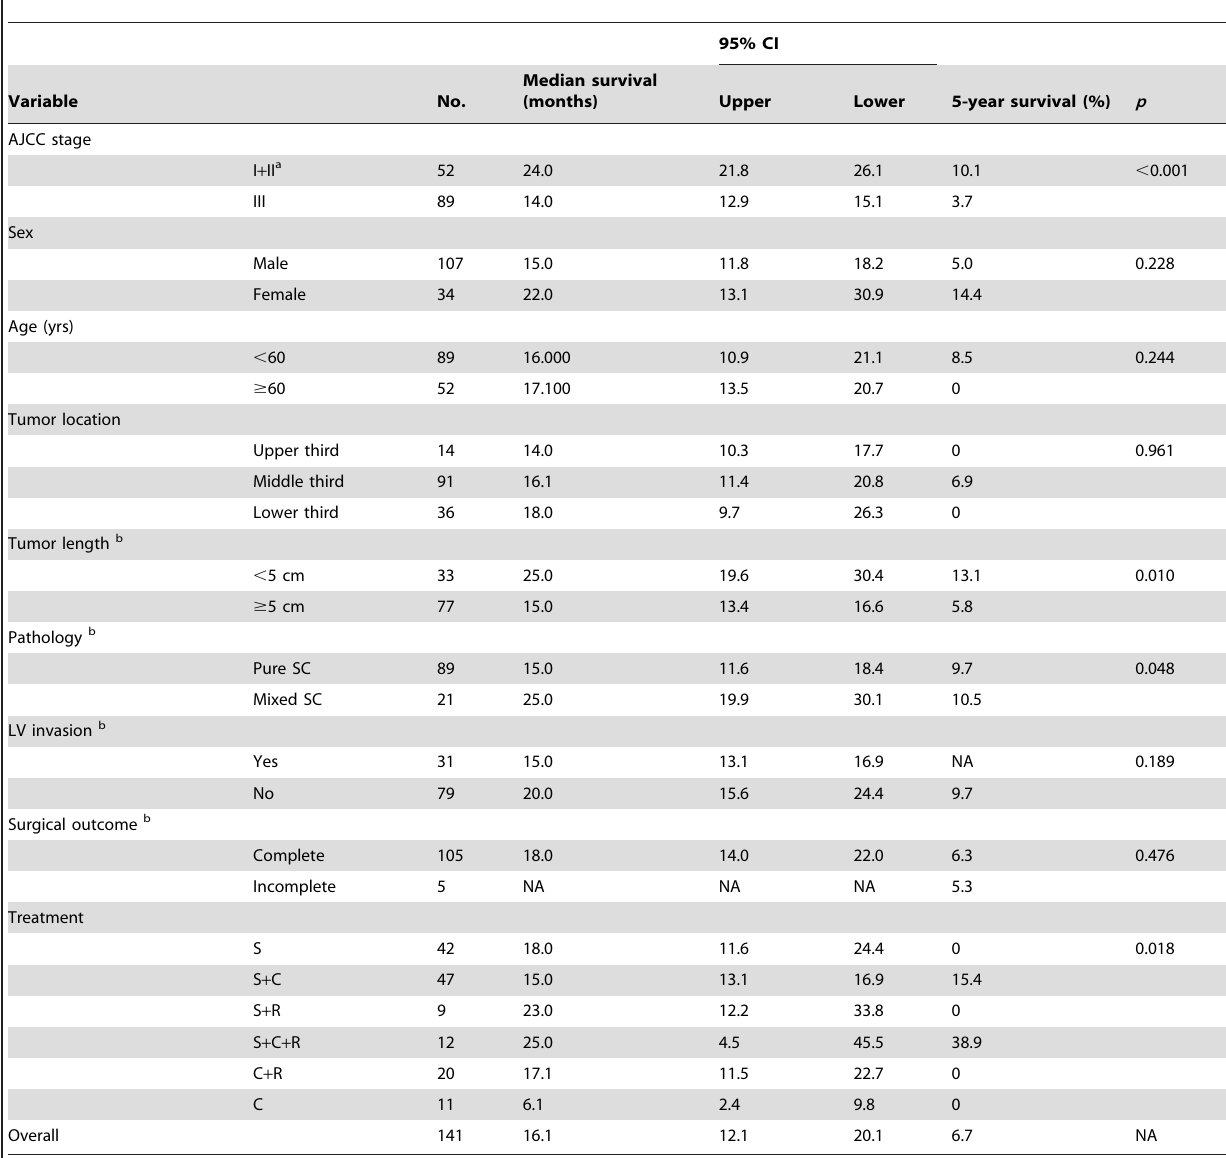
Table 3. Overall survival for subgroups and the entire cohort of patients (n